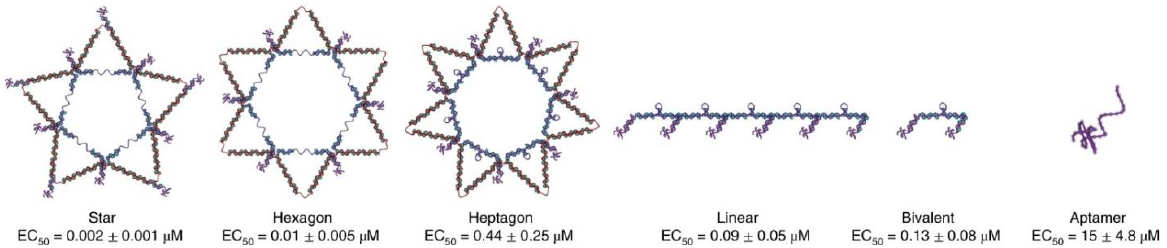
Figure 5. A schematic representing the inhibitory nanostructures for dengue virus with their corre- sponding mean EC50 (half maximal effective concentration) values. The hexagonal spacing resulted in reduced detection compared to the star-shaped spacing, despite its being the correct spacing. The schematic for the star and hexagon shows an unzipped hairpin region because potent pattern match- ing occurs. Other scaffolds represent the hairpins as stem – loop structures to indicate a lack of potent pattern matching ([5]).